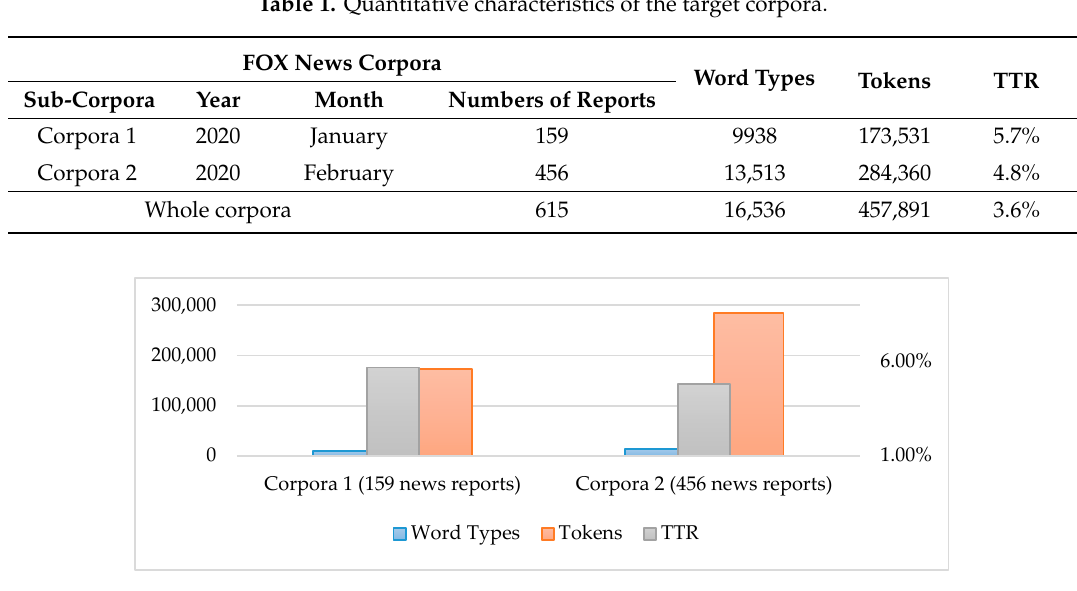
Figure 5. Quantitative characteristics of the target corpora.